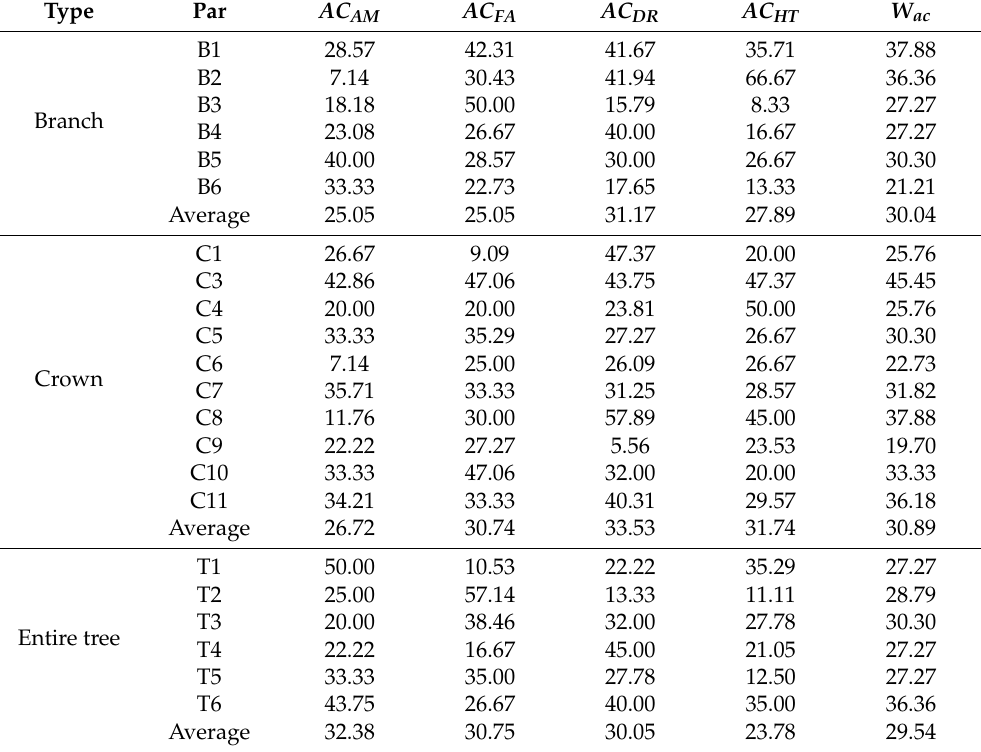
Table 3. Overall weighted accuracy ( W ac ) of four species using each parameter and the classification accuracy of four species ( AC AM , AC FA , AC DR , AC HT ) using each parameter. Par indicates the name of structural parameters. Type demonstrates the group of structural